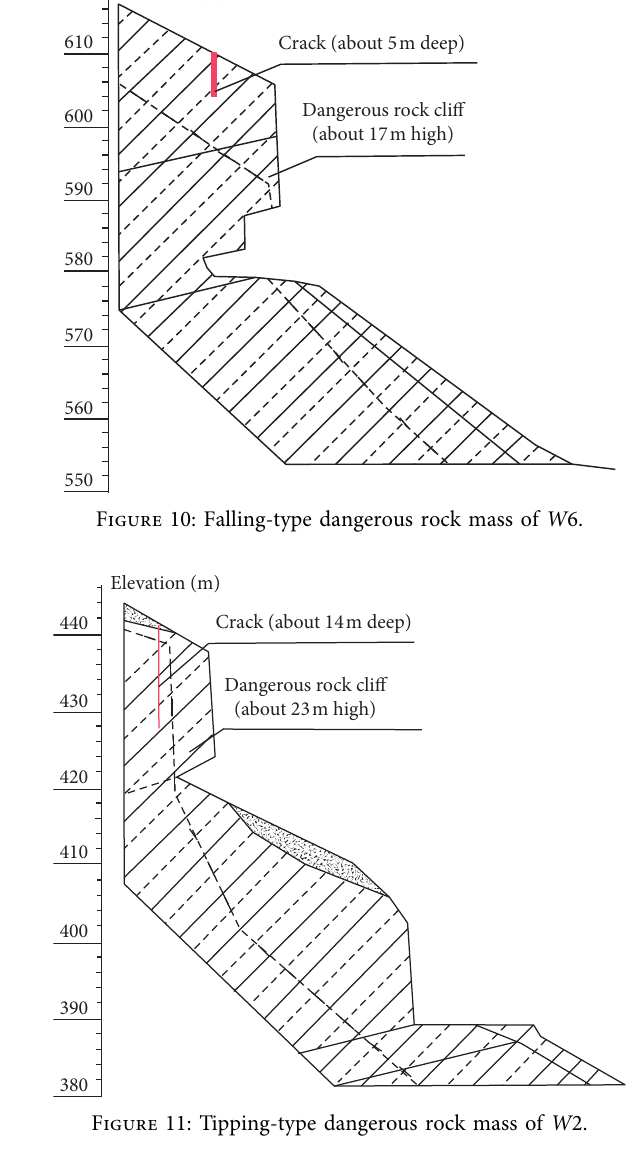
Figure 9: Falling-type dangerous rock mass of W 4.